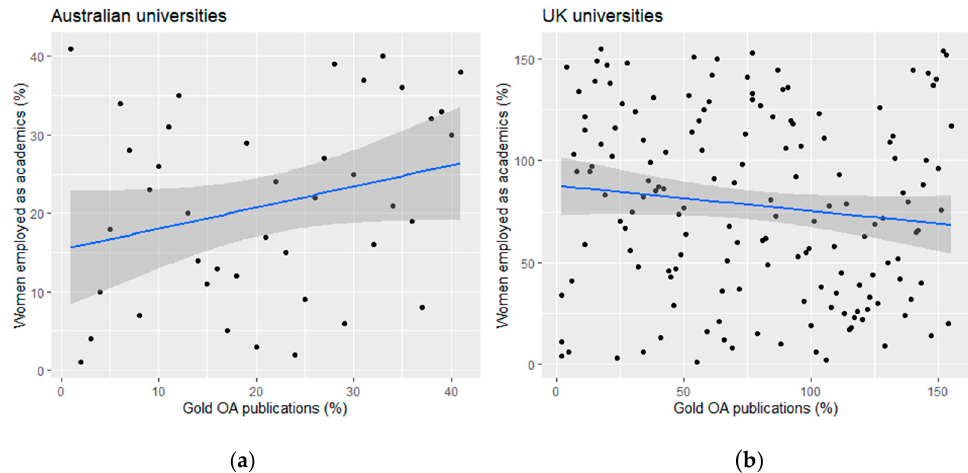
Figure 1. Scatterplot shows correlations between ranks in percentages of women in academic roles and percentages of Gold (publisher) OA output across ( a ) 41 Australian and ( b ) 155 United Kingdom